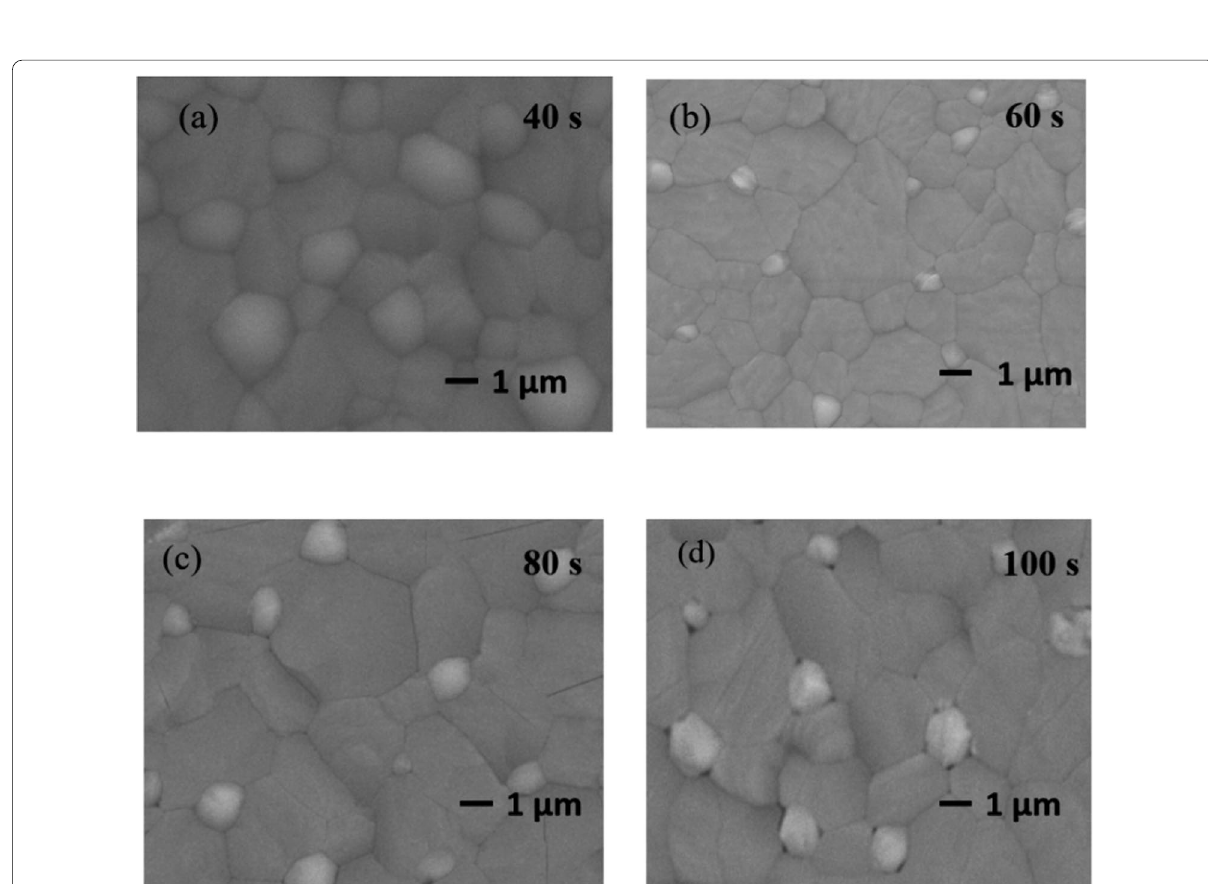
Fig. 9 SEM images of CsPbBr 3 films annealed at 460 ℃ for different